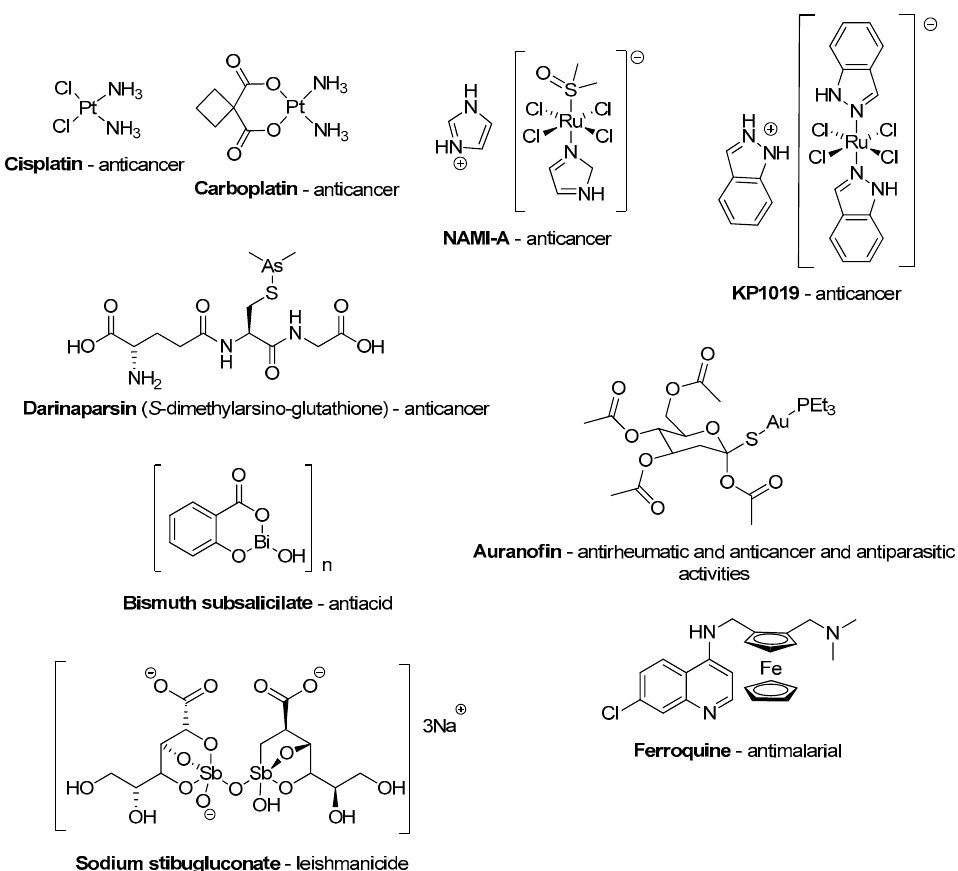
Figure 4. Some examples of applied metallodrugs or those in the advanced trial stage.